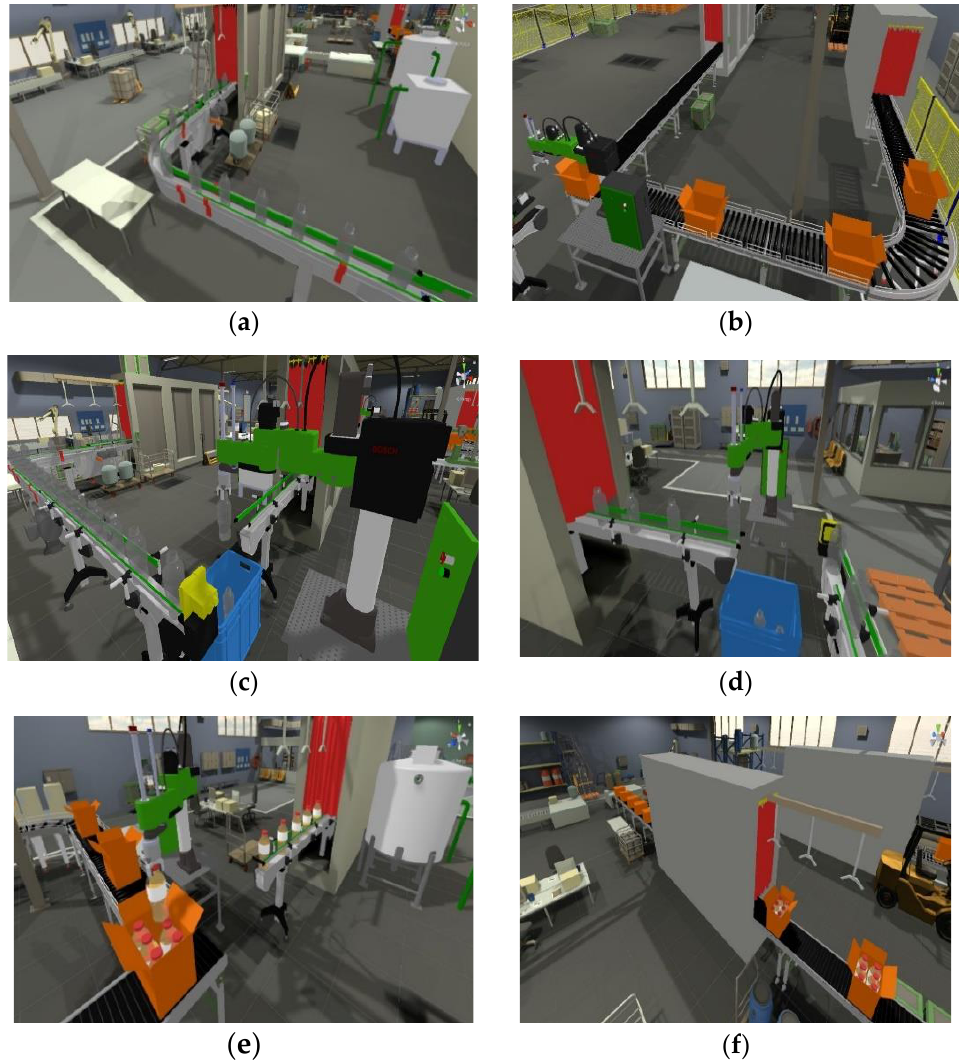
Figure 11. Description of the stages of the industrial environment applied to the automatic bottle filling process using robotic systems. ( a ) Disinfecting and transfer of bottles. ( b ) Assembly and transfer of boxes. ( c ) Failure detector for bottles. ( d ) Filling, capping and labeling. ( e ) Bottle packaging. ( f ) Sealing